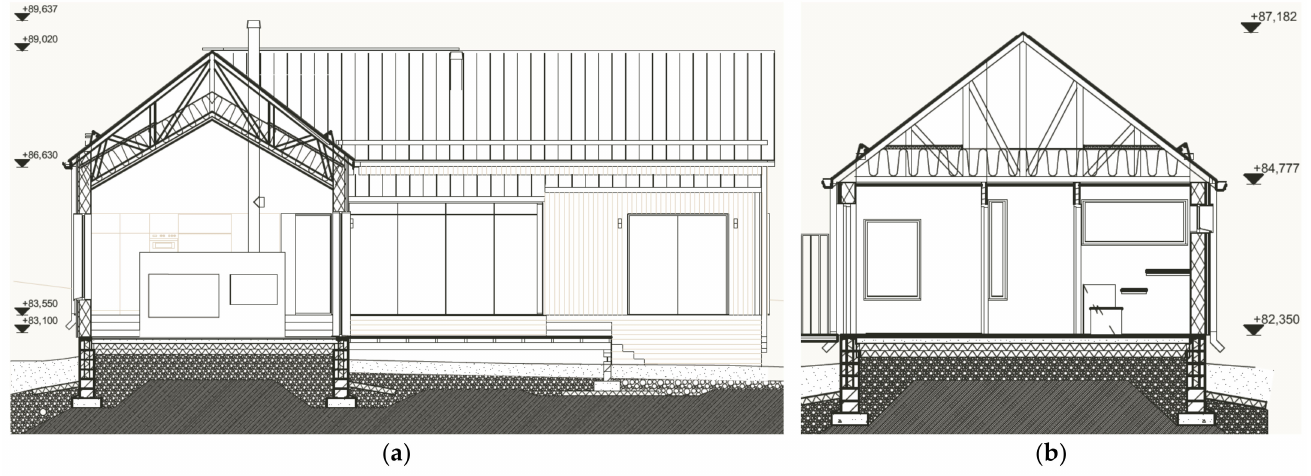
Figure 14. Sections: ( a ) A-A; ( b )